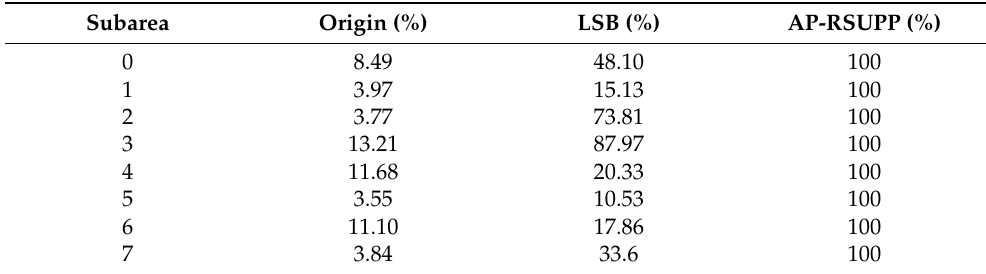
Table 9. Proportion of very-high-risk areas to subareas and percentage patrolled by LSB and UPP